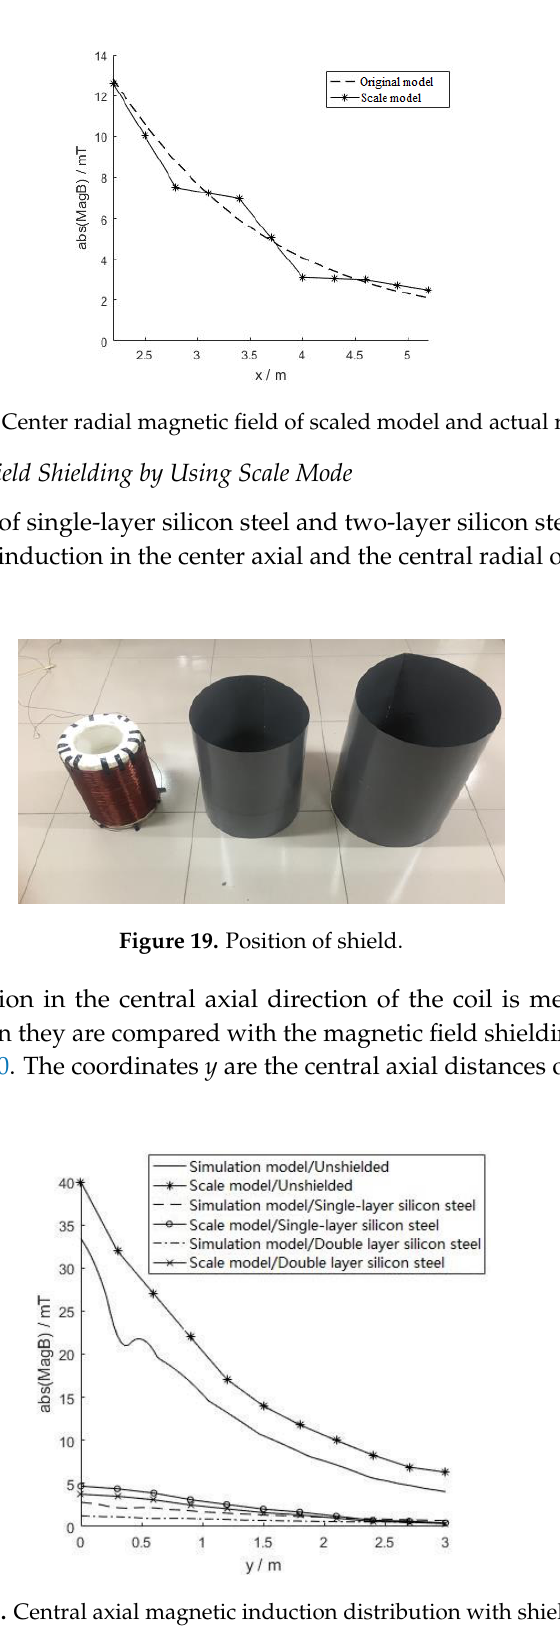
Figure 17. Central axial magnetic field of scaled model and actual reactor.